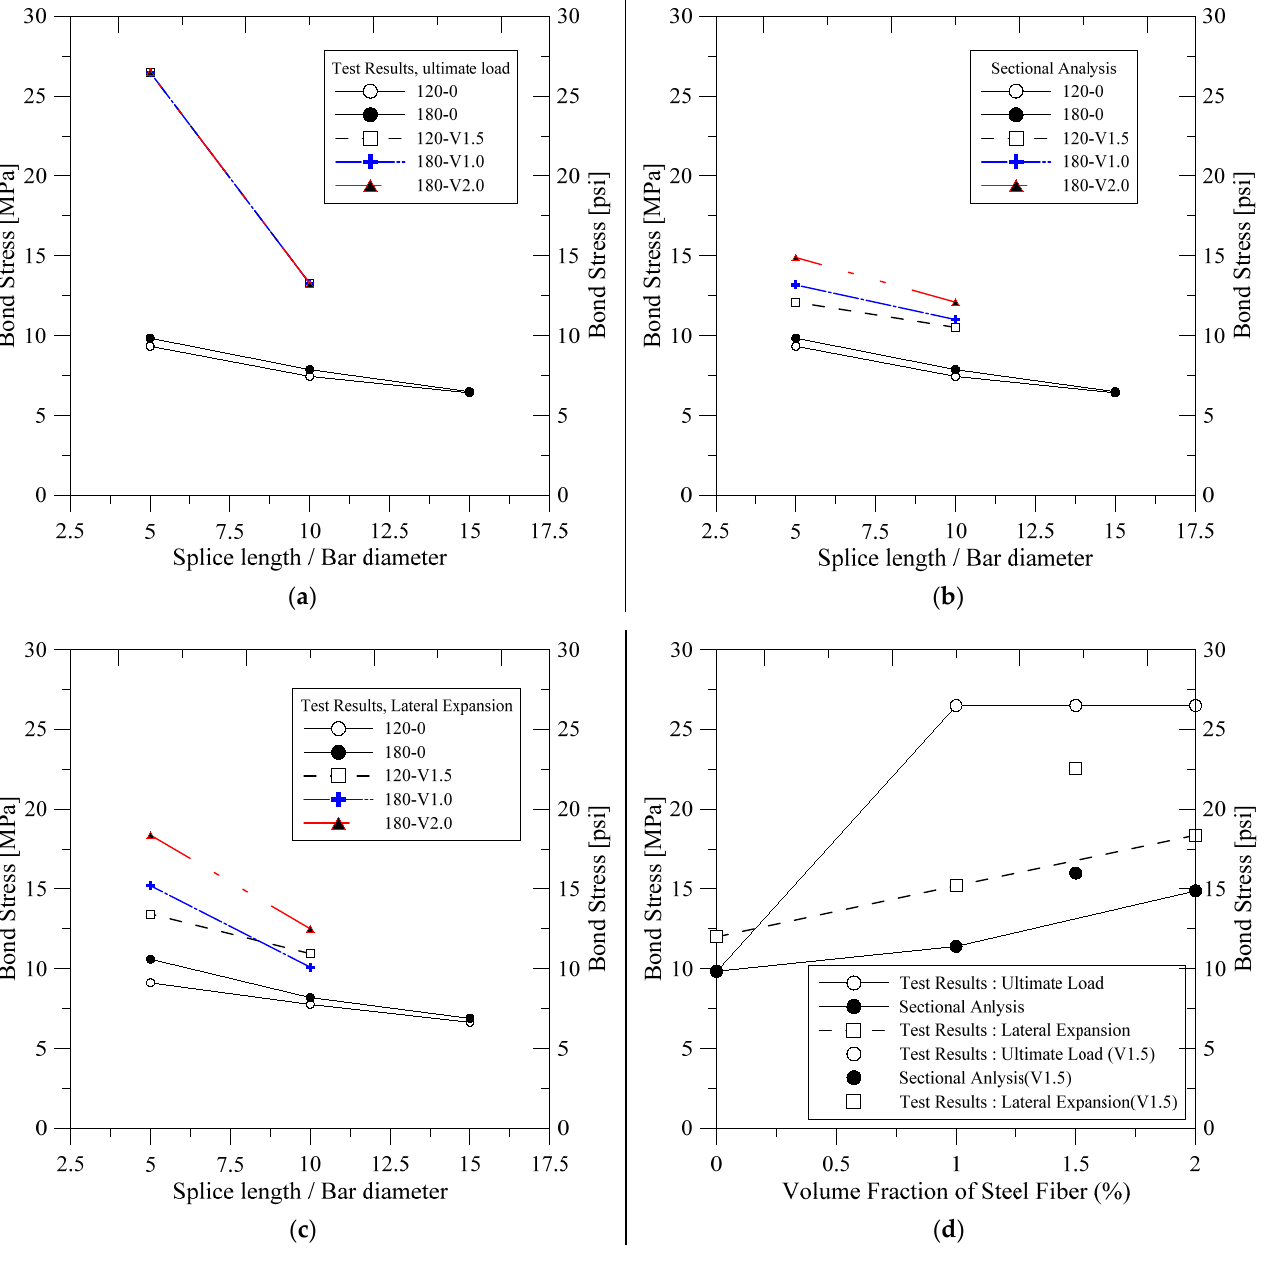
Figure 13. Average bond stress at lap-spliced region: ( a ) Bond stress calculated based on the ultimate load of test specimens; ( b ) Bond stress calculated based on the sectional analysis results; ( c ) Bond stress calculated based on the lateral expansion of bottom of the test specimen; ( d ) Bond stress–steel fiber volume fraction relation.